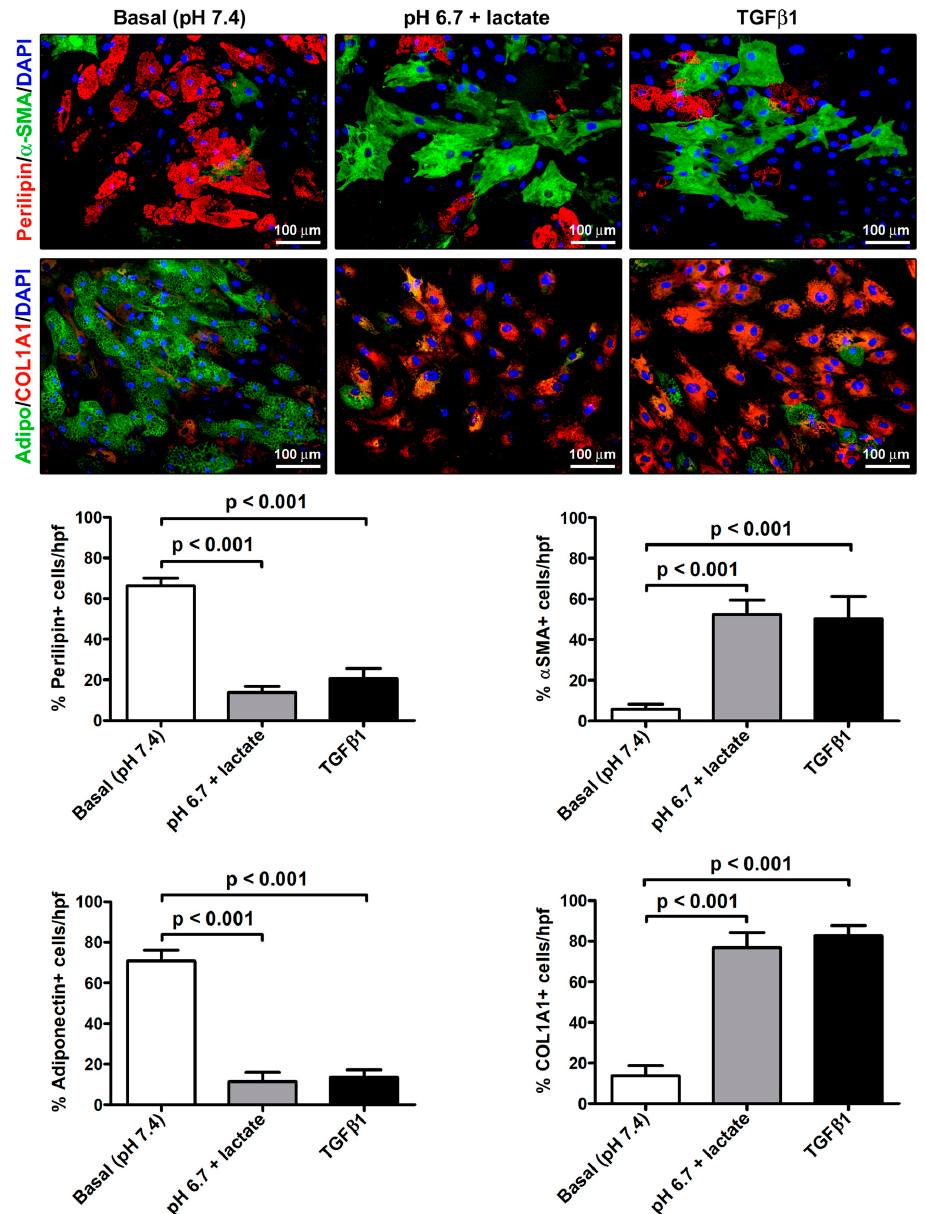
Figure 5. Immunofluorescence analysis for the expression of the adipocytic markers perilipin-1 (red, upper panels) and adiponectin (green, lower panels), and the myofibroblastic markers α -SMA (green, upper panels) and COL1A1 (red, lower panels) in adipocyte-committed adipose-derived stem cells grown for 3 days under basal (pH 7.4) conditions, lactic acidosis (pH 6.7 + lactate), or in the presence of 10 ng/mL TGF β 1. Nuclei are stained blue with DAPI. Scale bar: 100 µ m. Bars represent the mean ± SEM of the percentage of immunopositive cells/high-power field (hpf). Values of p were determined by Tukey(cid:31)s test.